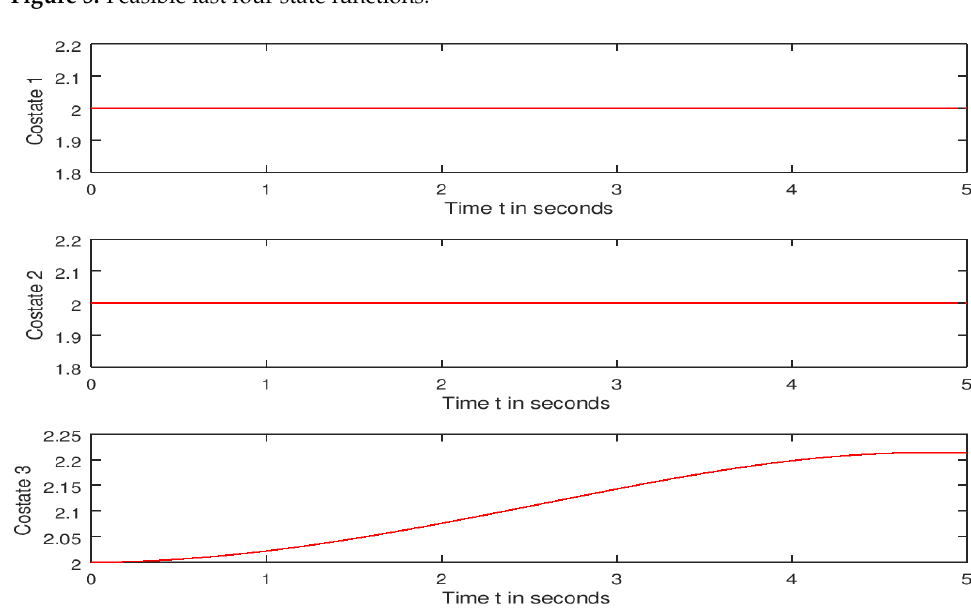
Figure 5. Feasible last four state functions.